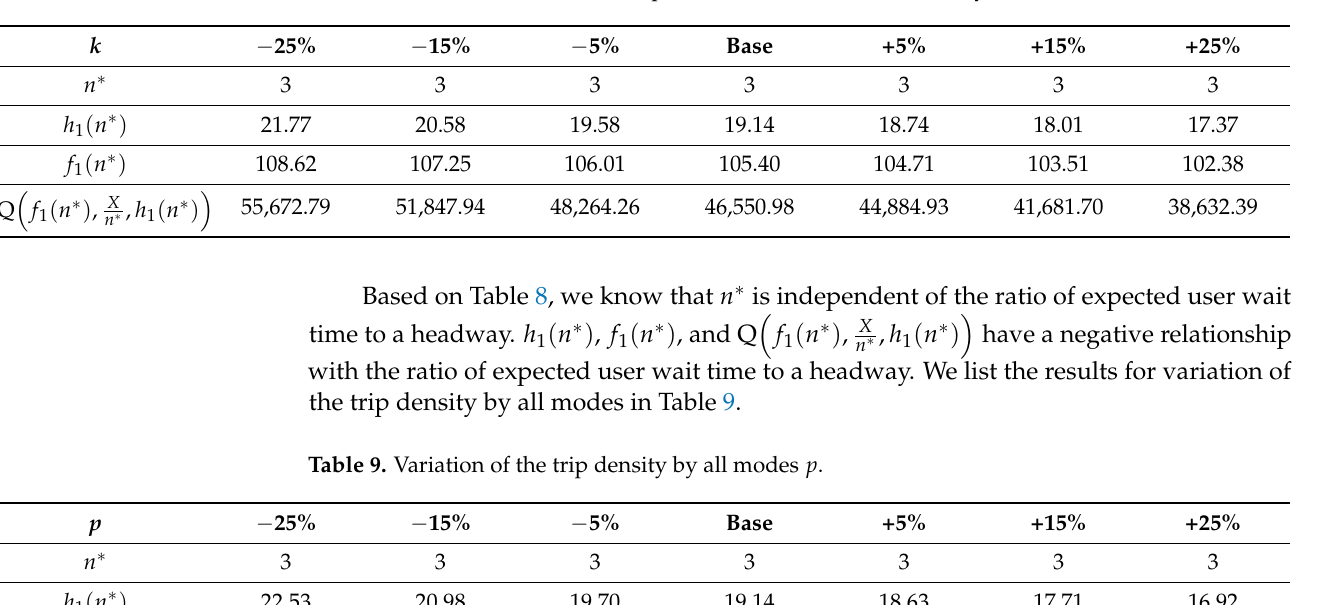
Table 8. Variation of the ratio of expected user wait time to headway k .